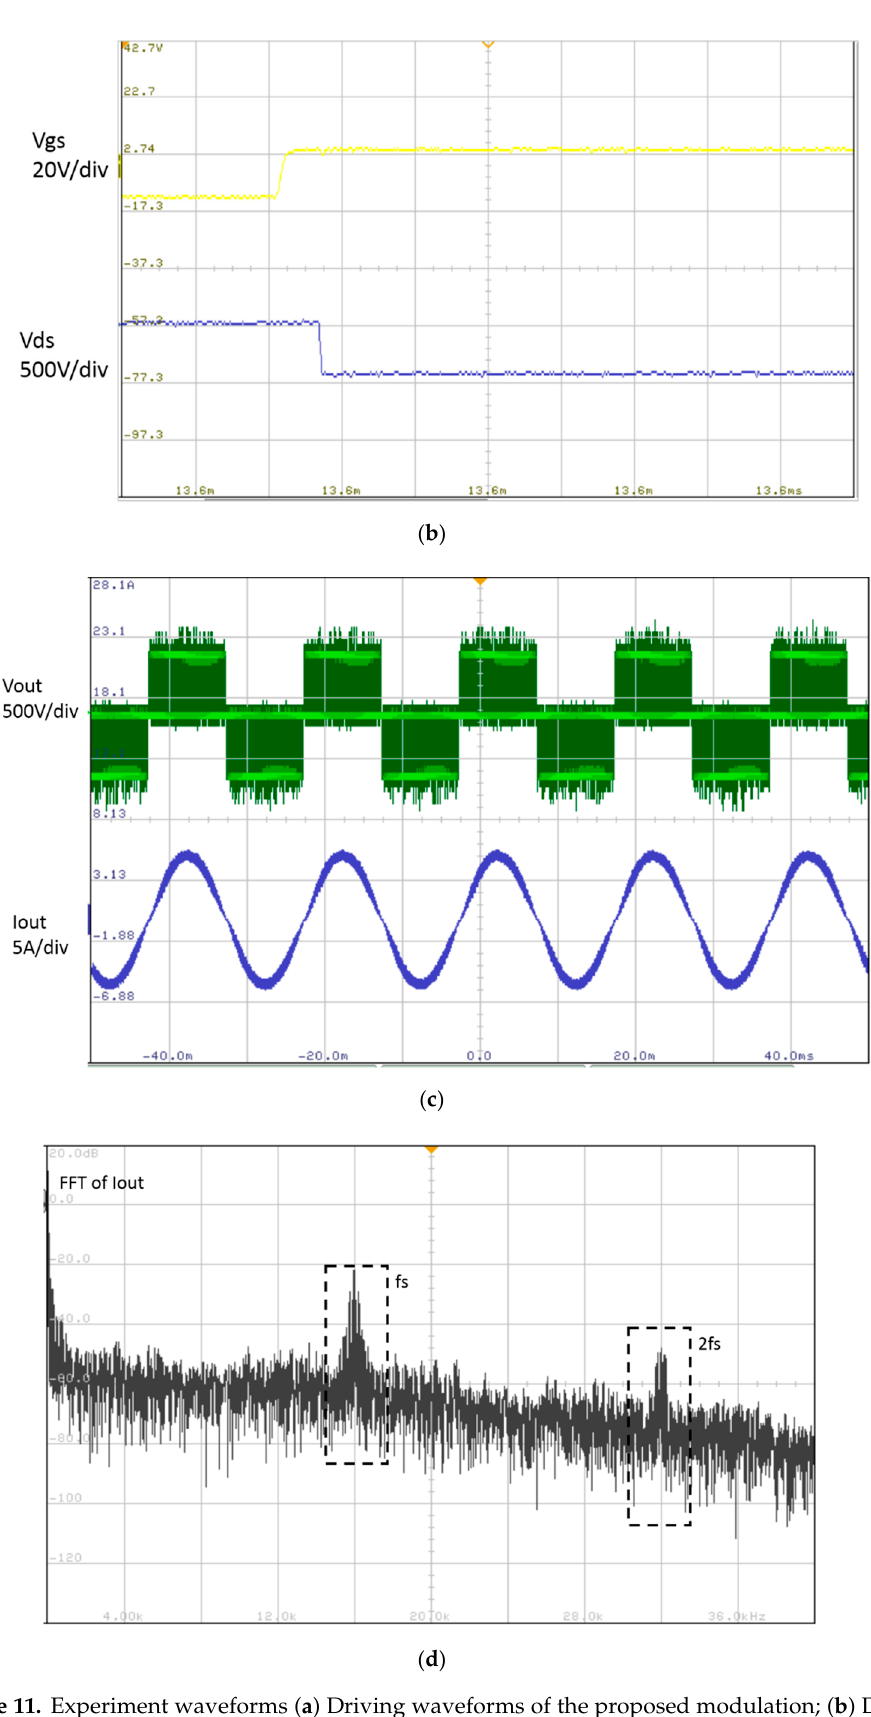
Figure 11. Experiment waveforms ( a ) Driving waveforms of the proposed modulation; ( b ) Driving voltage and voltage across the device; ( c ) Output voltage and current waveform at 3 A output current; ( d ) FFT of Iout.